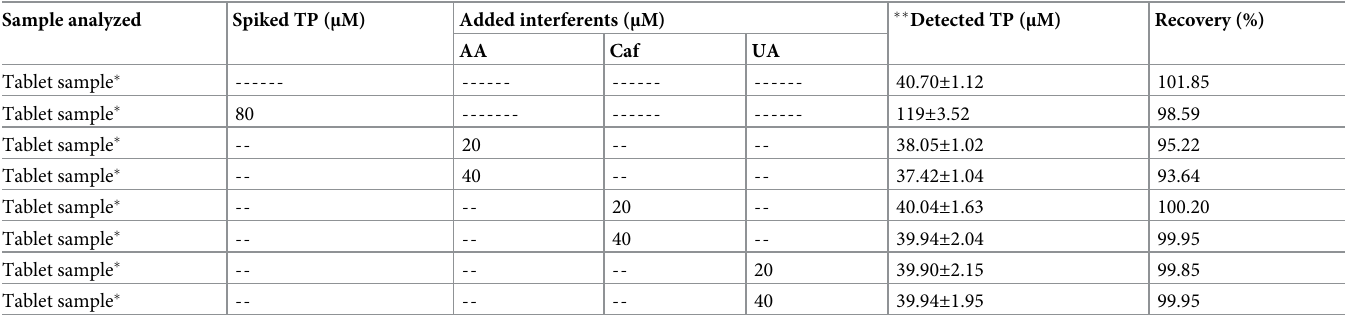
Table 2. Summary of the detected level of TP (mean ± SD for n 3) in tablet formulation, spike recovery, and interference recovery results of the developed method. Sample analyzed